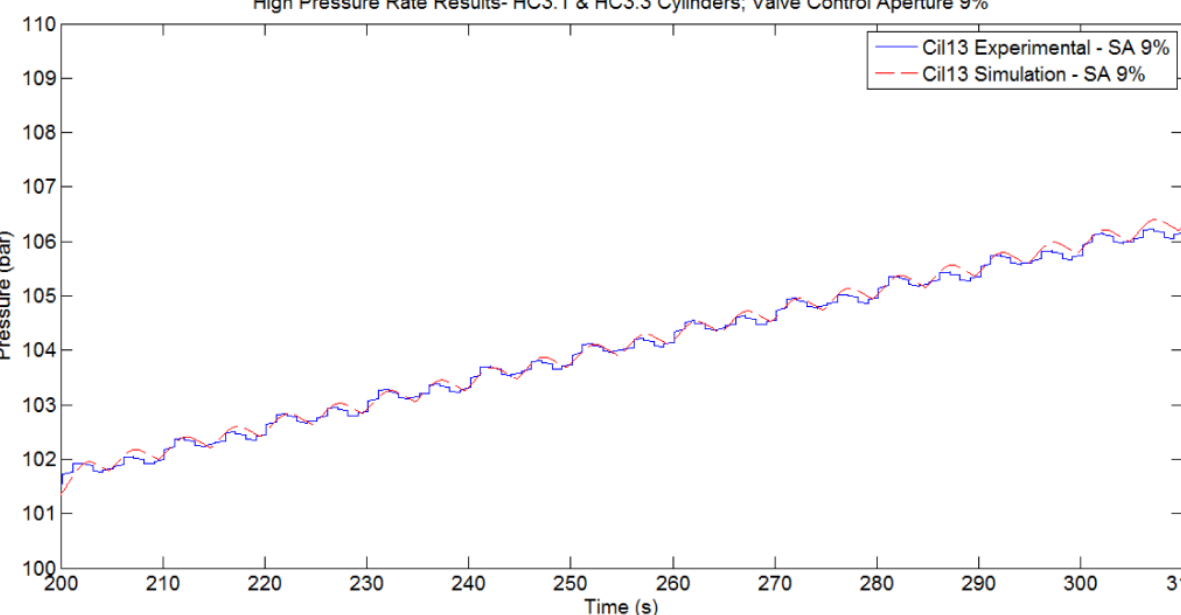
Figure 25. Comparison between Simulated and Experimentally Measured pressure of HP Accumulator. Active cylinders HC3.1 and HC3.3. Valve Control Aperture 9%. Initial Pres. 101.5 bar. Geometrical layout: Config